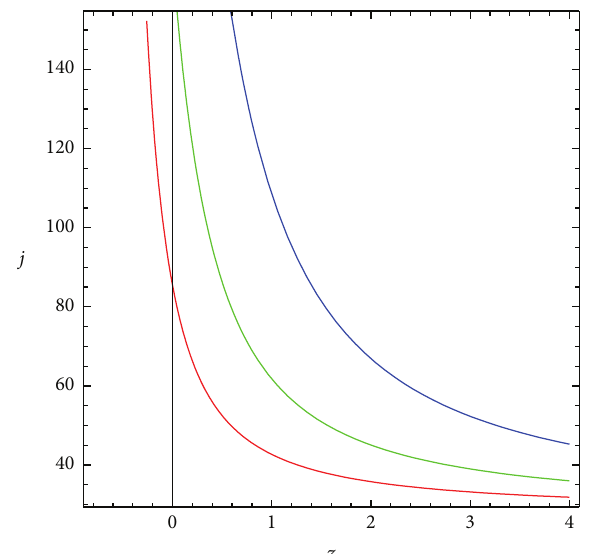
Figure 20: Jerk parameter plot against redshift 𝑧 corresponding to